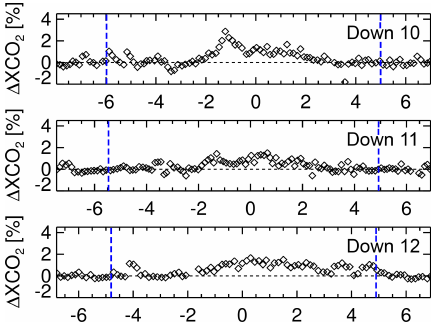
Figure 14. MAMAP XCO 2 measurement transects for the three flight legs downwind of the power plant Frimmersdorf. The area outside the dashed vertical lines denote the data that were used for the normalisation.